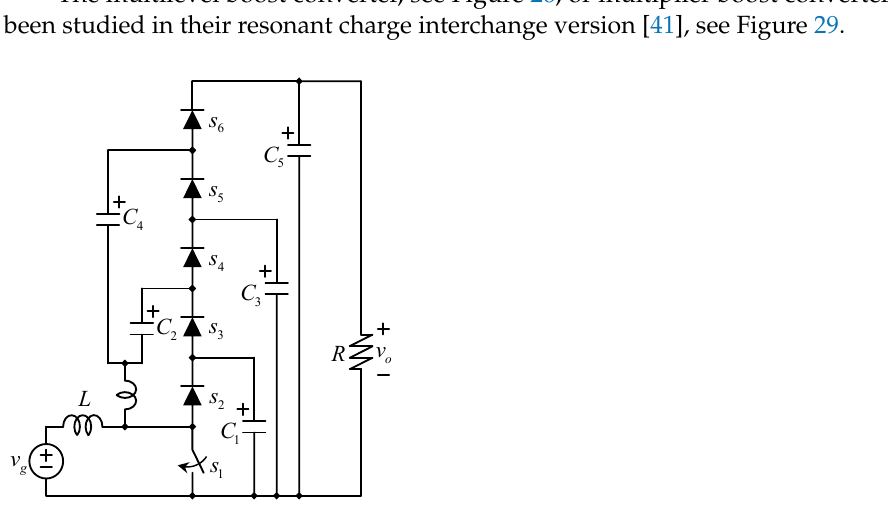
Figure 29. The Multilevel boost converter with resonant charge interchange [41]. A modified version of the converter in Figure 9 has been investigated in [107] (see Figure 30). It consists of a cascaded connection of two converters with convenient modifi- cations to produce a resonant charge interchange.